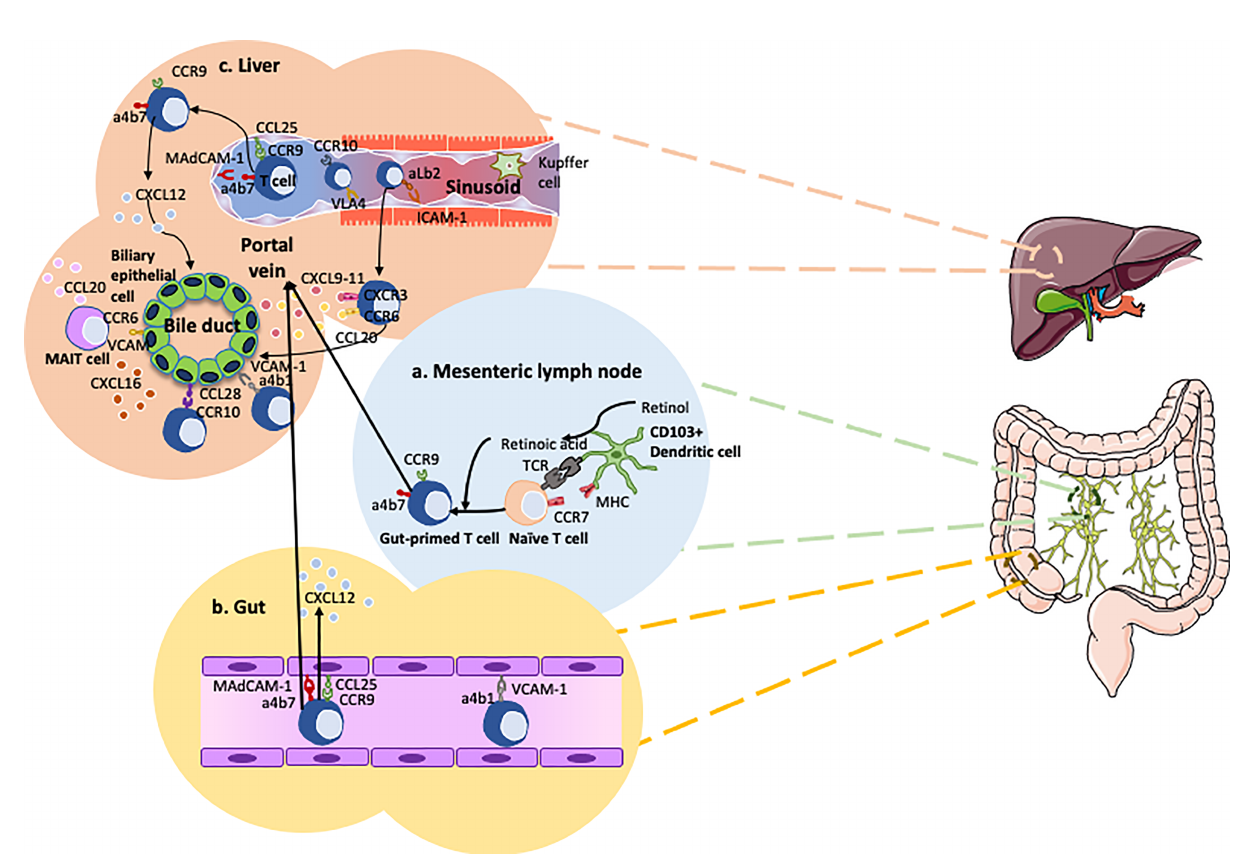
FIGURE 2 | Overview of the gut-liver axis homing of cells in primary sclerosing cholangitis (PSC). (A) Dendritic cells recognize pathogens penetrating the mucosal barrier and subsequently migrate to the mesenteric lymph node to present their antigens to naïve T cells (82). These naive T cells are imprinted with the gut-homing integrin a 4 b 7 and chemokine receptor CCR9 via the transformation of retinol into retinoic acid. (B) The gut-primed T cells recirculate into the gut bind onto the endothelium of the blood vessels via interactions between MAdCAM-1 and a 4 b 7 , CCL25 and CCR9. (C) CCR10 expressing Tregs and gut-primed memory T cells expressing a 4 b 7 and CCR9 migrate from the gut to the liver via the portal vein. These concepts are applied in PSC to develop new therapies such as Vedolizumab. Chemokine CXCL12 is thought to play a role in maintaining CCR9+ lymphocytes around the bile ducts